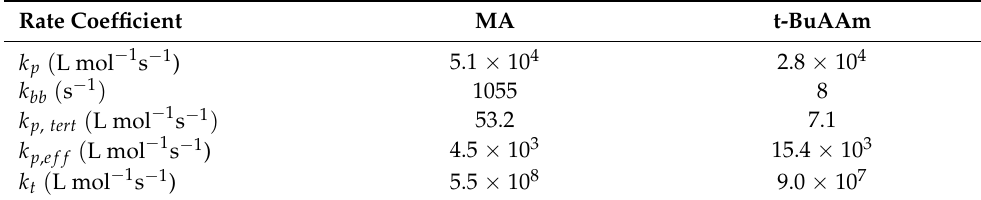
Table 1. Rate coefficients for MA and t-BuAAm radical homopolymerizations with 20 wt% monomer in 75/25 EtOH/H 2 O at 70 ◦ C, as calculated from the rate expressions reported in Table S2. Rate